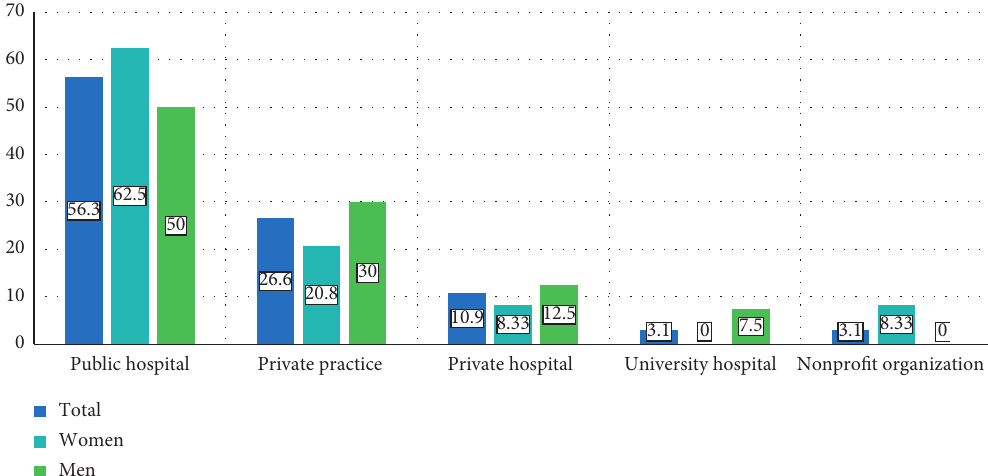
Figure 1: Main workplace of rheumatologists in Ecuador.